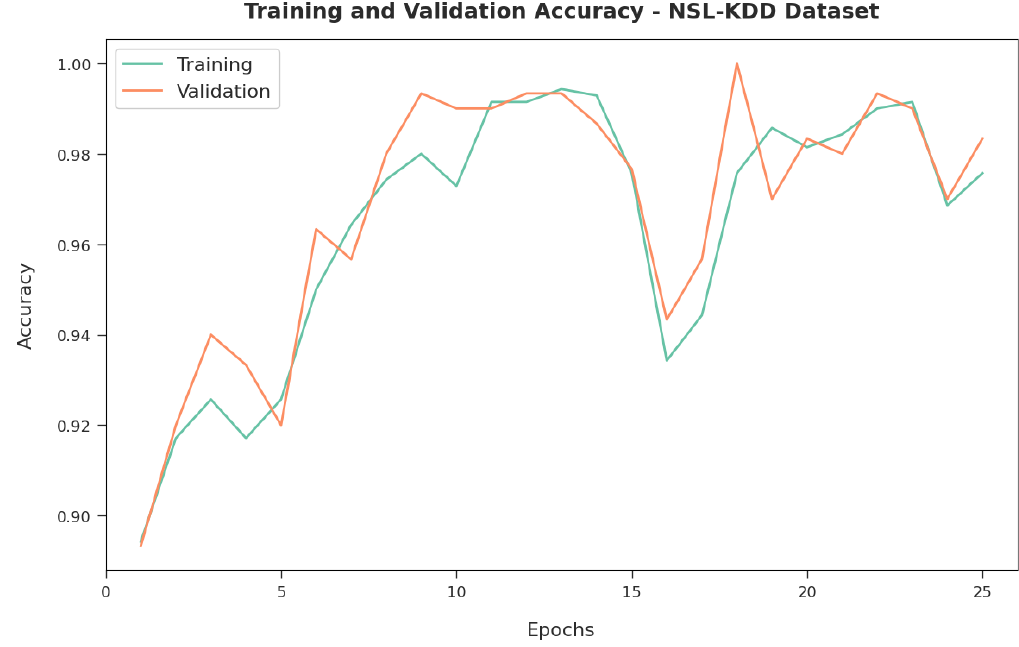
Figure 4. TA and VA analysis of OMLIDS-PBIoT technique under NSL-KDD dataset.